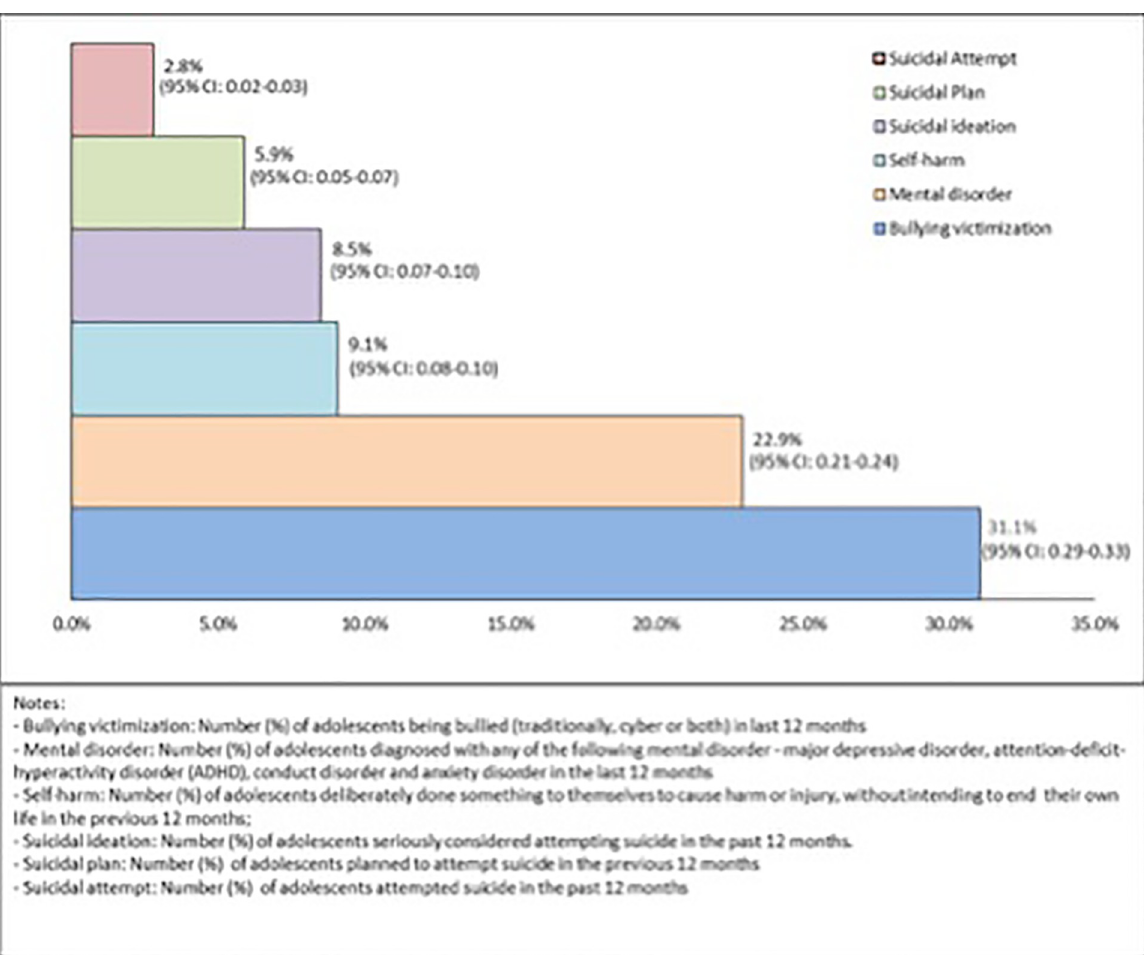
Fig 1. Prevalence (%) of mental health problems with 95% Confidence Interval (CI) in the sample population. Bullying victimization: Number (%) of adolescents being bullied (traditional, cyber or both) in last 12-months. Mental disorder: Number (%) of adolescents diagnosed with any of the following mental disorder—major depressive disorder, attention-deficit-hyperactivity disorder (ADHD), conduct disorder and anxiety disorder in the last 12-months. Self-harm: Number (%) of adolescents deliberately done something to themselves to cause harm or injury, without intending to end their own life in the previous 12-months. Suicidal ideation: Number (%) of adolescents seriously considered attempting suicide in the past 12-months. Suicidal plan: Number (%) of adolescents planned to attempt suicide in the previous 12-months. Suicidal attempt: Number (%) of adolescents attempted suicide in the past